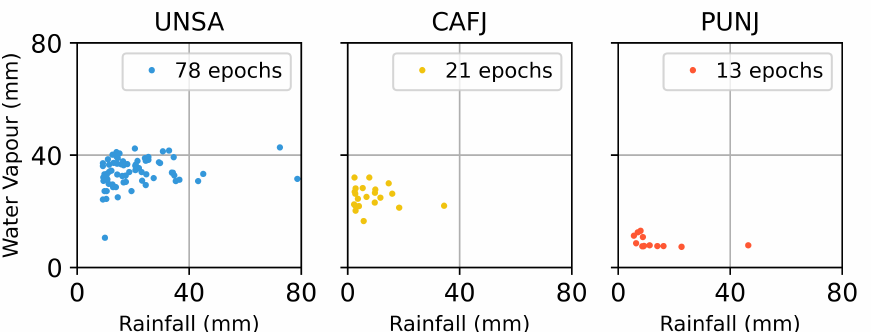
Figure 10. Quantile–quantile (Q-Q) plots of the greater than the 75th percentile daily-summed rainfall against the corresponding daily mean water vapour values of UNSA, CAFJ, and PUNJ stations. The lower number of measurements (epochs) in the higher-altitude stations is explained by the lower frequency of rainfall occurrences.